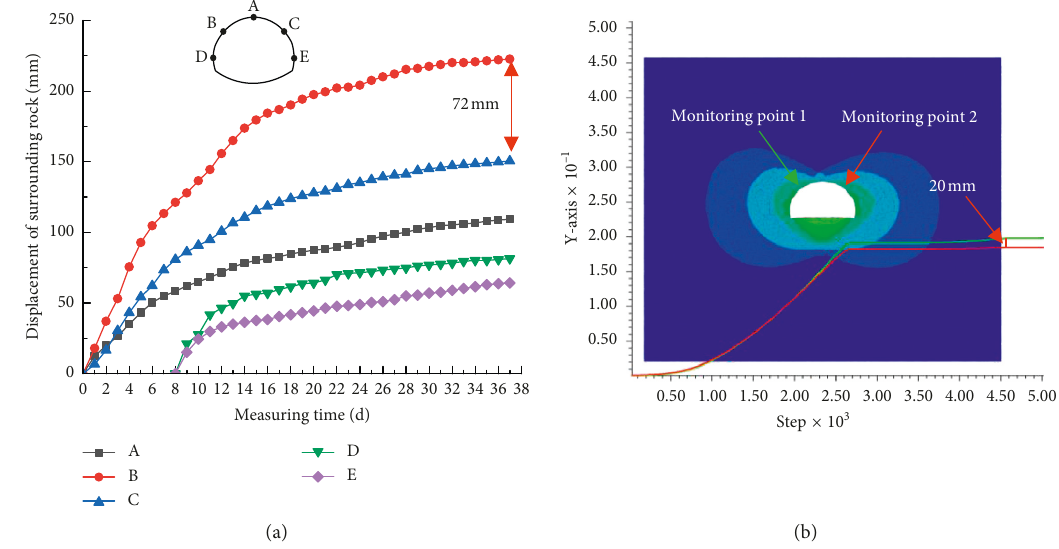
Figure 24: (a) Field test results. (b) Numerical simulation